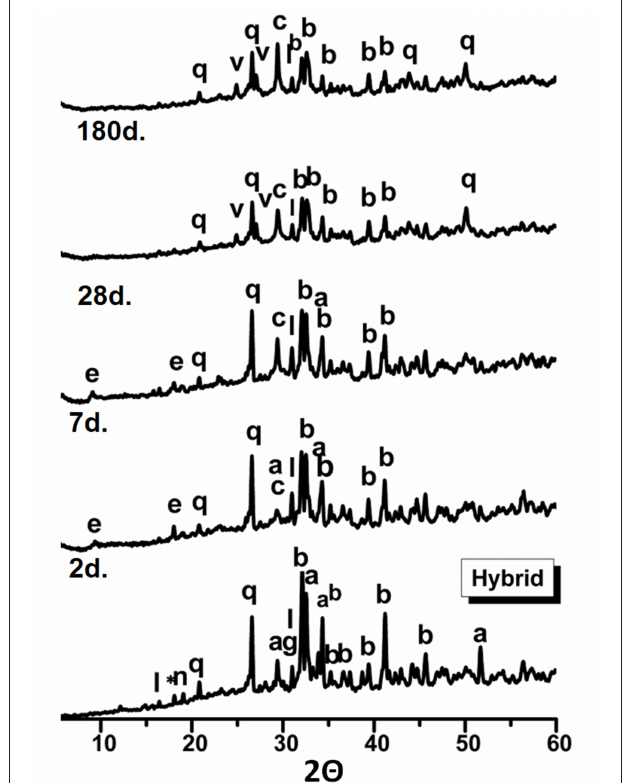
FIGURE 2 | Anhydrous and 2 d, 7 d, 28 d, and 180 d hydrated paste diffractograms Legend: b, C 2 S(86-0398); a , C 3 S(70-8632); q , quartz